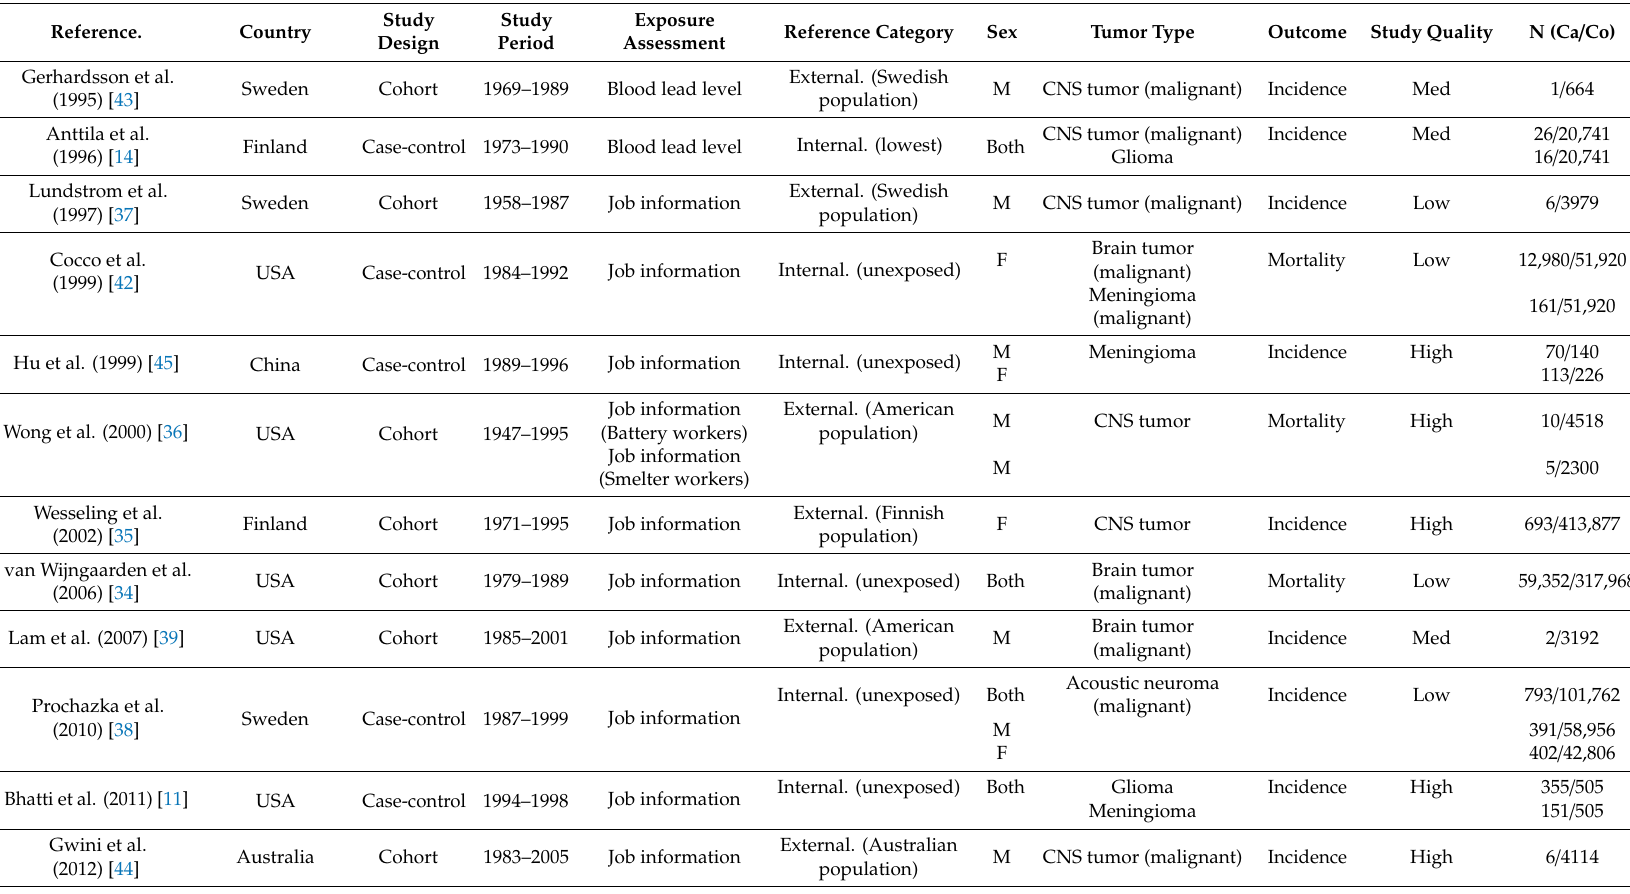
Table 1. Characteristics of included